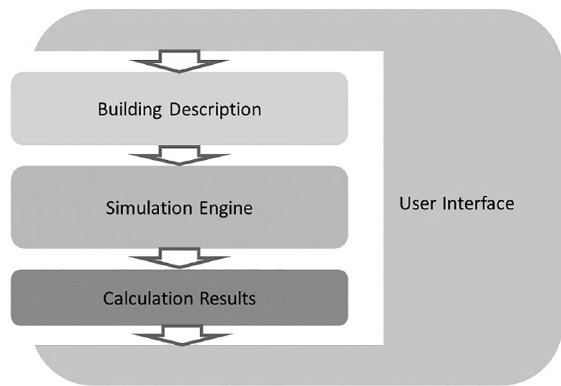
Figure 4. The general architecture of a building performance simulation tool (Maile et al.,